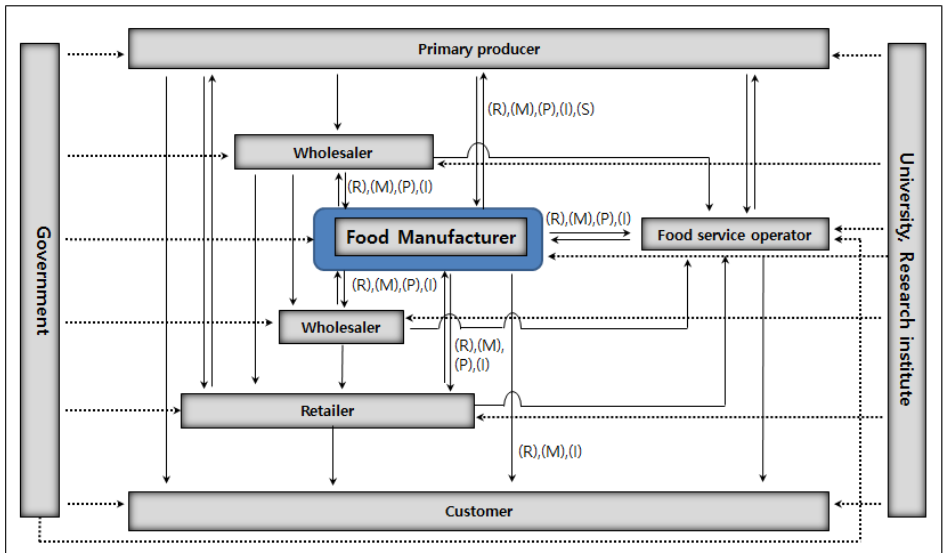
Figure 1. Food industry value chain centered on food manufacturers and expected alliances among their stakeholders. Notes: (R), (M), (P), (I), and (S) indicate the purposes of alliance between two stakeholders: (R), R&D; (M), marketing and sales; (P), production; (I), investment; (S), supply of raw